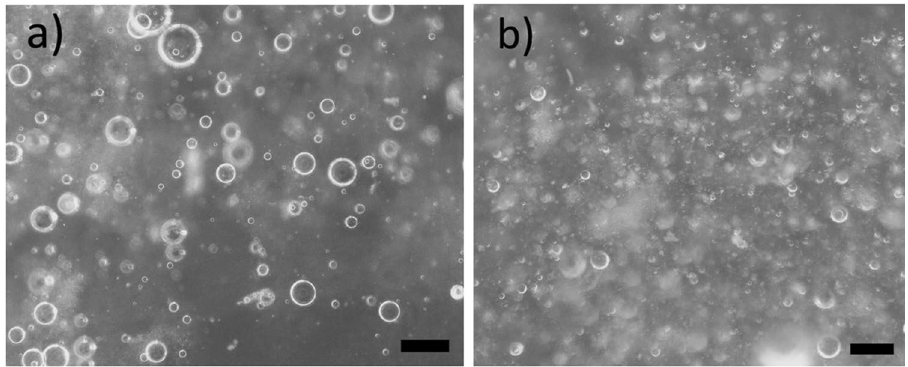
Figure 9. Optical microscopy images of water in oil emulsions sampled following bottle tests conducted using toluene (10% v/v), 0.25 M lauric acid in canola oil (10% v/v) and either 30 mM CuCl 2 solutions (70% v/v, a) or